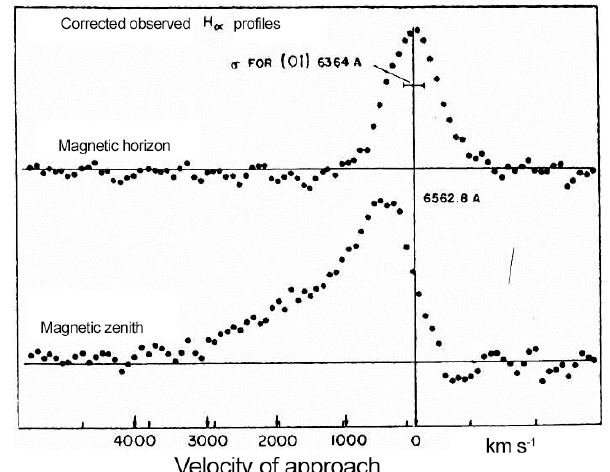
Figure 5. A Doppler shift of the H β line towards the violet mea- sured in kilometers per second during an intense aurora on 19 Au- gust 1950. According to Meinel (1950), the observed shift of more than 7nm corresponds to a proton velocity of 3200kms − 1 .